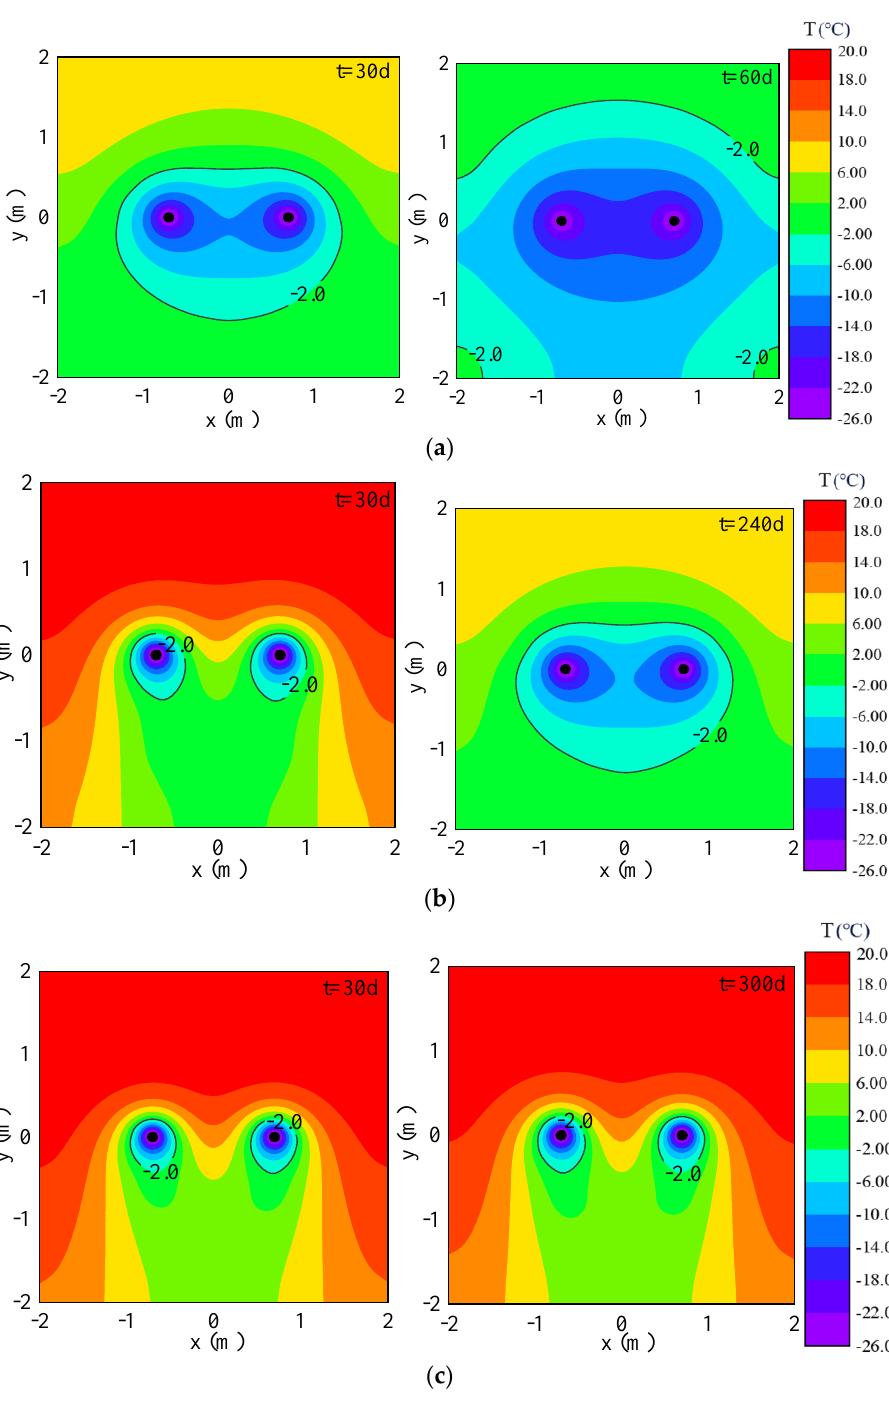
30 days of freezing (Figure 8a). When the groundwater seepage velocity is 1.5 m/d,